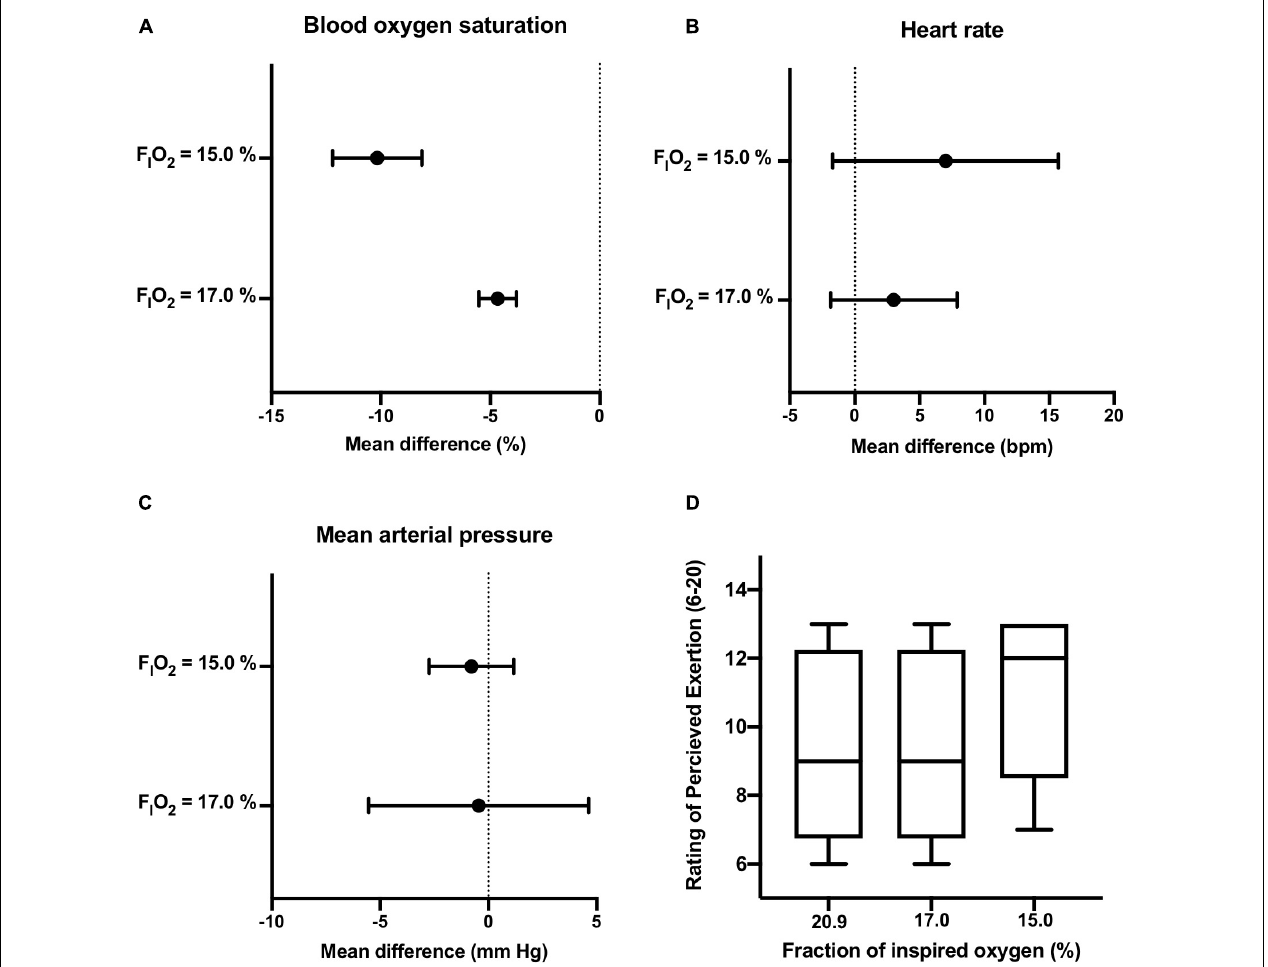
FIGURE 2 | Active Progressive Normobaric Hypoxia Exposure. Effects of reducing F I O 2 on blood oxygen saturation [panel (A) ], heart rate [panel (B) ], mean arterial blood pressure [panel (C) ], and rating of perceived exertion [panel (D) ] during constant workload exercise. Data reported as mean difference and 95% confidence interval for the difference between normoxia (F I O 2 = 20.9%) and the two levels of normobaric hypoxia (F I O 2 = 17.0, and 15.0%). The box and whisker plots [panel (D) ] report the median along with the 25th and 75th percentiles and range (min to max) at the three levels of F I O 2 studied.